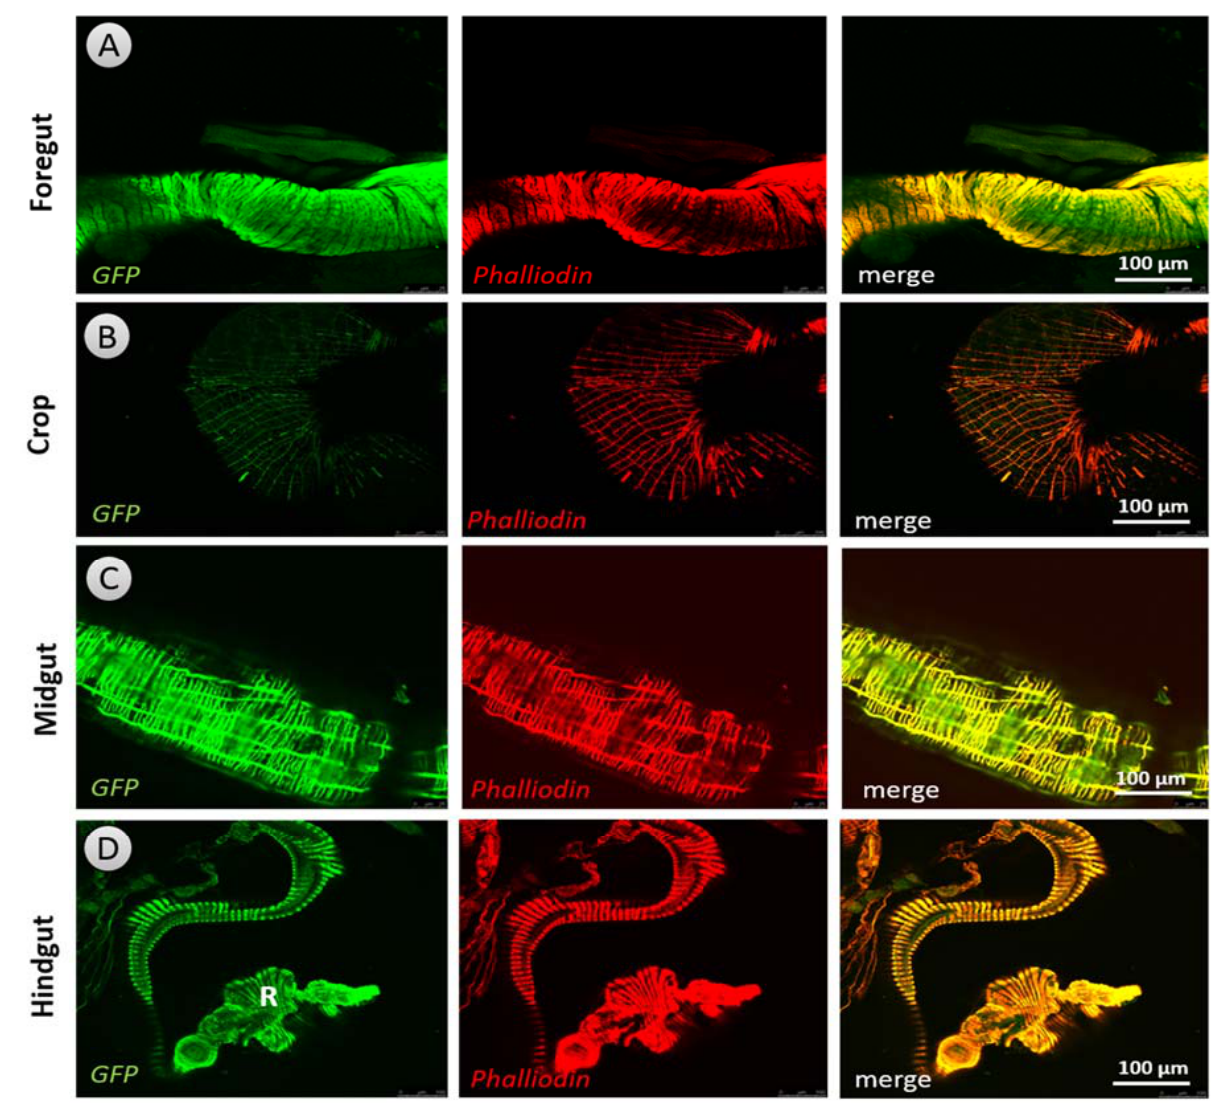
Figure 6. Dop1R1 expression pattern in adult flies’ (male and female) gut musculature stained immunohistochemically using anti-GFP antibody (green florescent micrograph) with phalloidin (red florescent micrograph), and the overlay of these two florescent micrographs revealed that almost all muscles express the Dop1R1 receptor: ( A ) foregut, ( B ) crop, ( C ) midgut, and ( D ) hindgut. R: rectum.